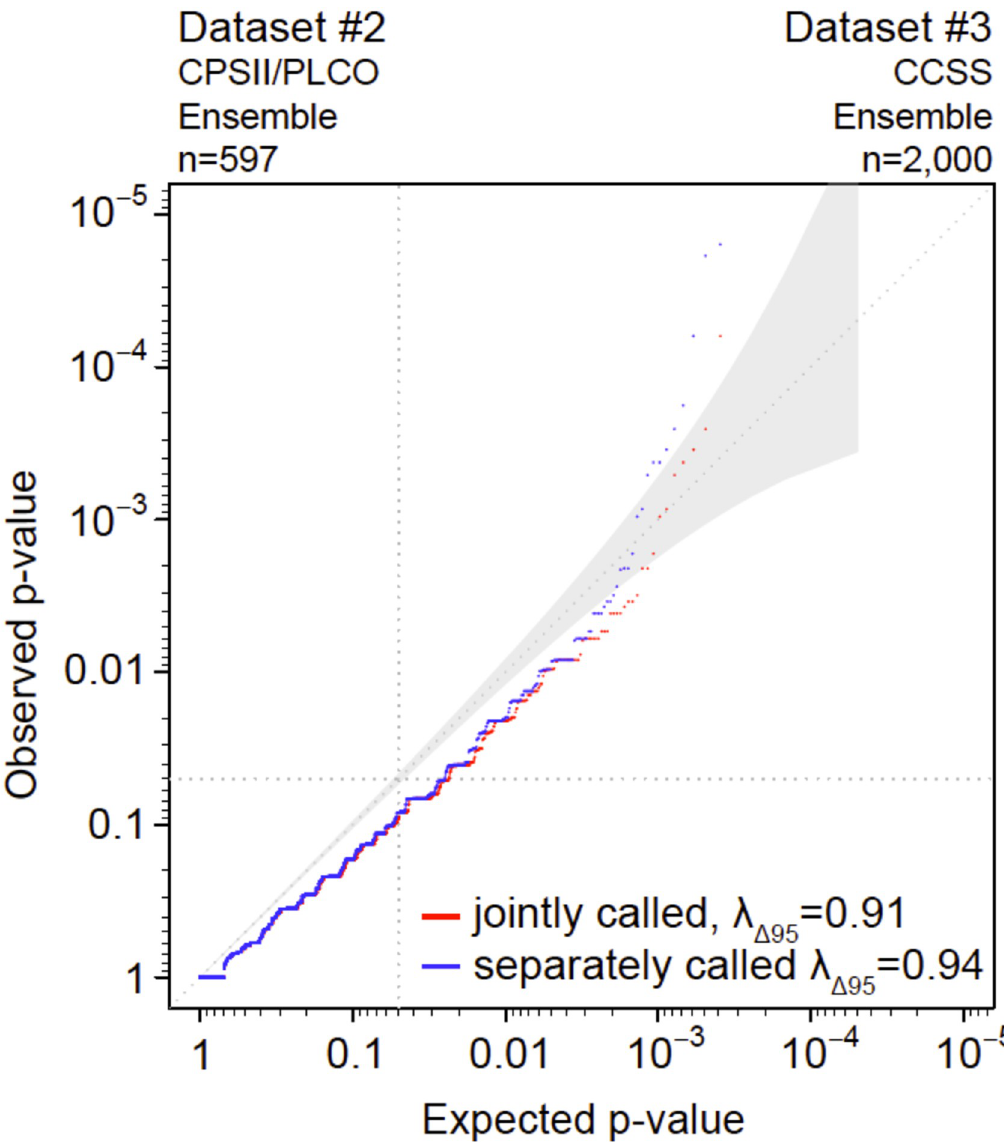
Fig 3. Evaluation of the effects of joint vs separate variant calling on elevated false-positive findings. Quantile-Quantile plot of sub-sampled CCSS data that were called jointly or separately. Red shows the two cohorts variant-called jointly; blue shows the two cohorts variant-called